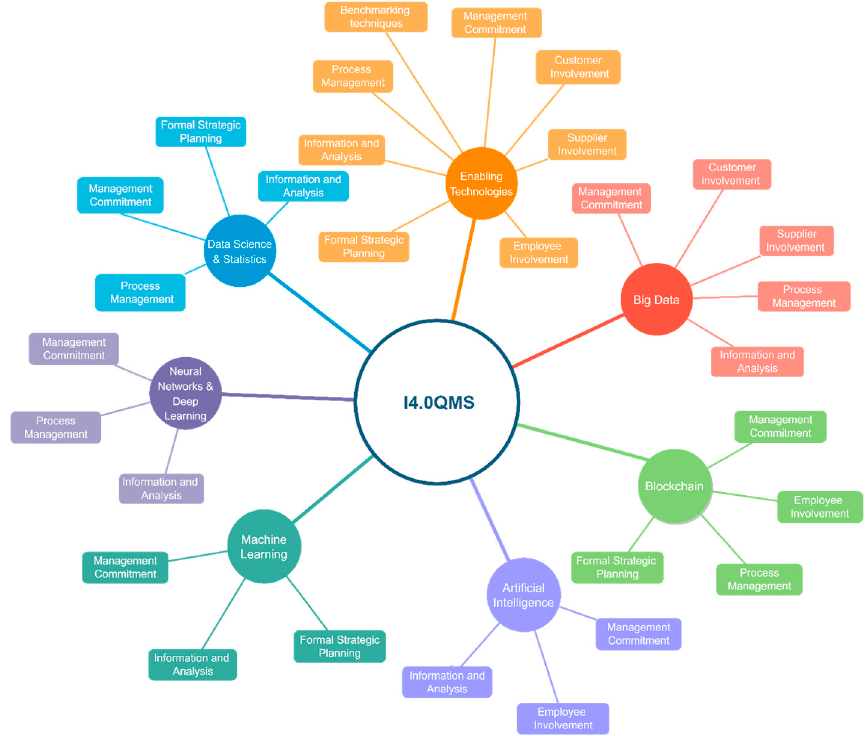
Figure 2. Relationship between Quality Management System practices and Industry 4.0 Tools, based on [13].